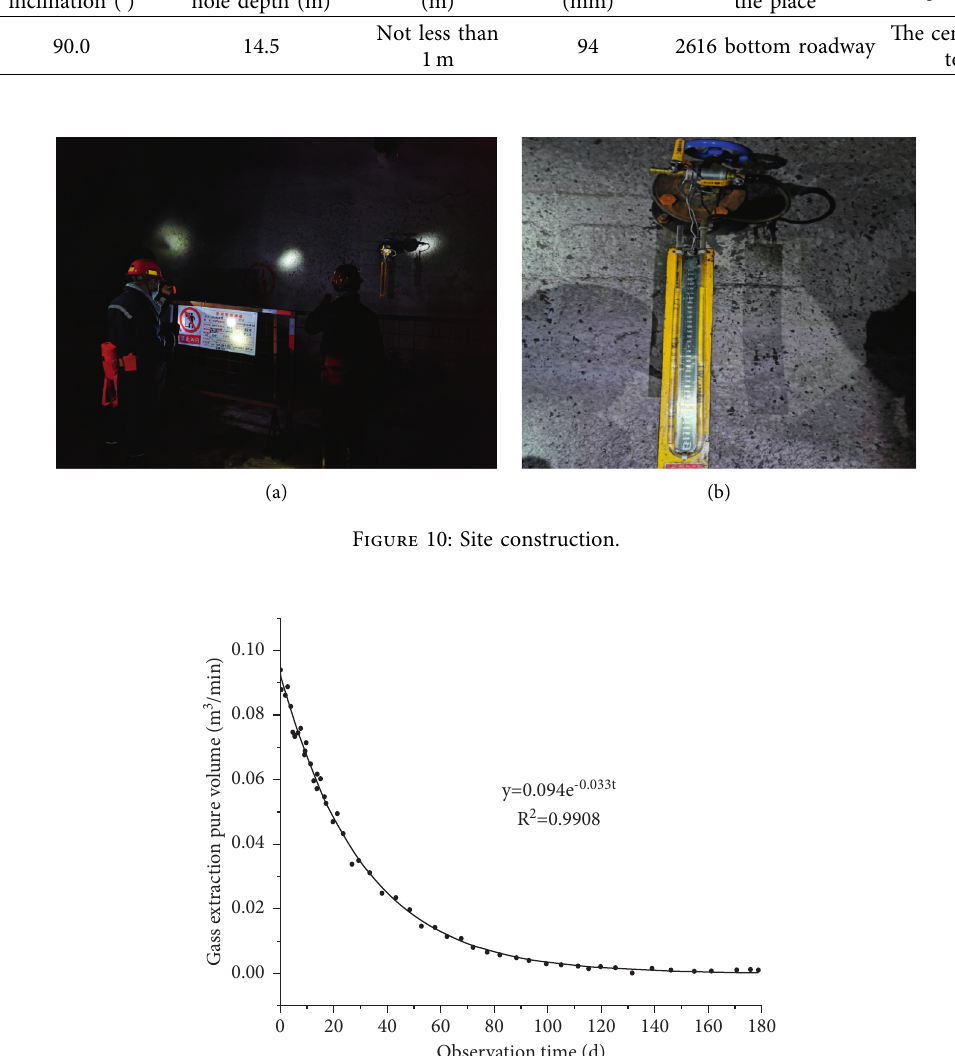
Figure 11: Variation law of drilling extraction pure quantity with extraction time in 26 mining areas of Juji Coal